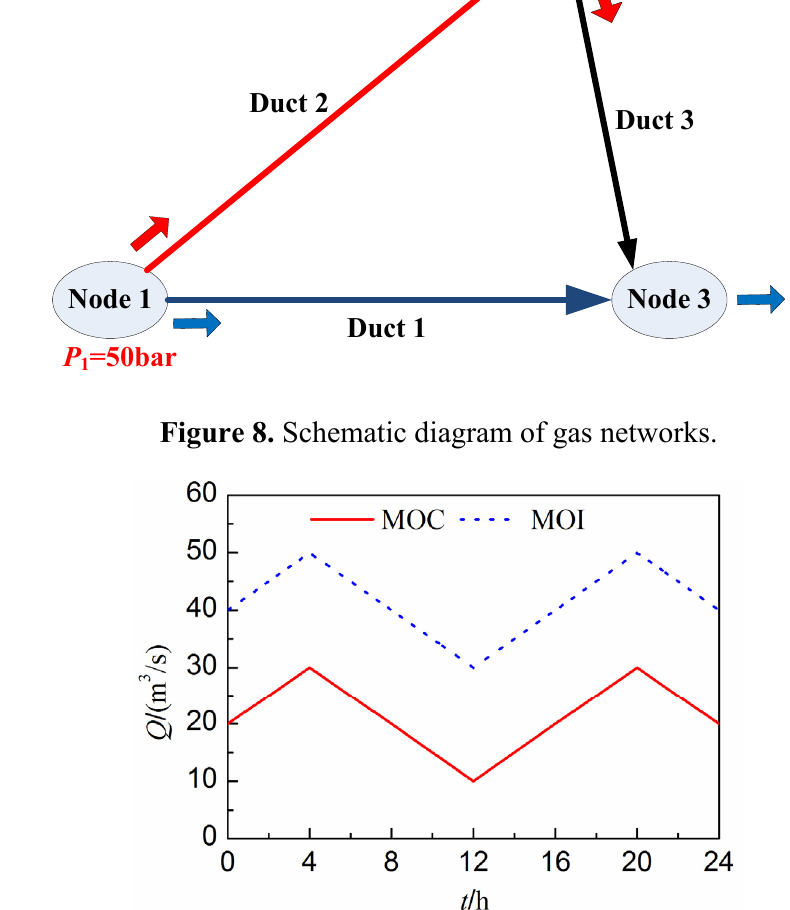
Figure 9. Gas demand at Nodes 2 and